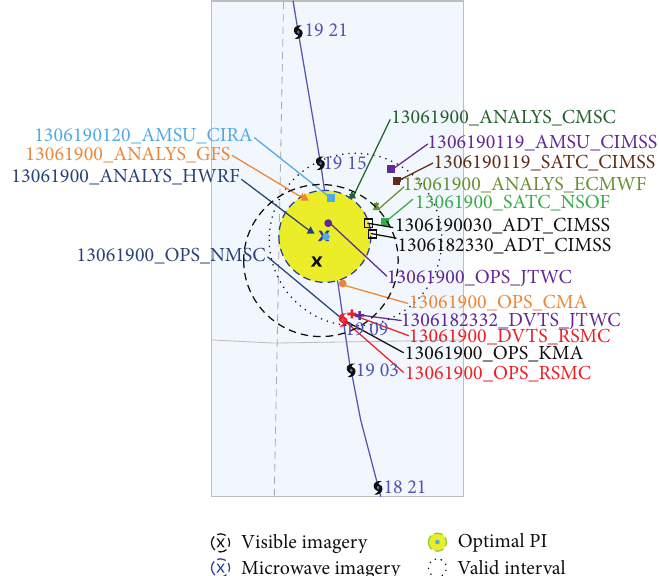
Figure 10: Overlaying the PIs and the valid interval on track chart at 00 UTC on 19 June, 2013, for Typhoon LEEPI (1304). “X” represents the estimated centers of the tropical cyclone from visible (black) and microwave (blue) imagery. The optimal PI is shaded.